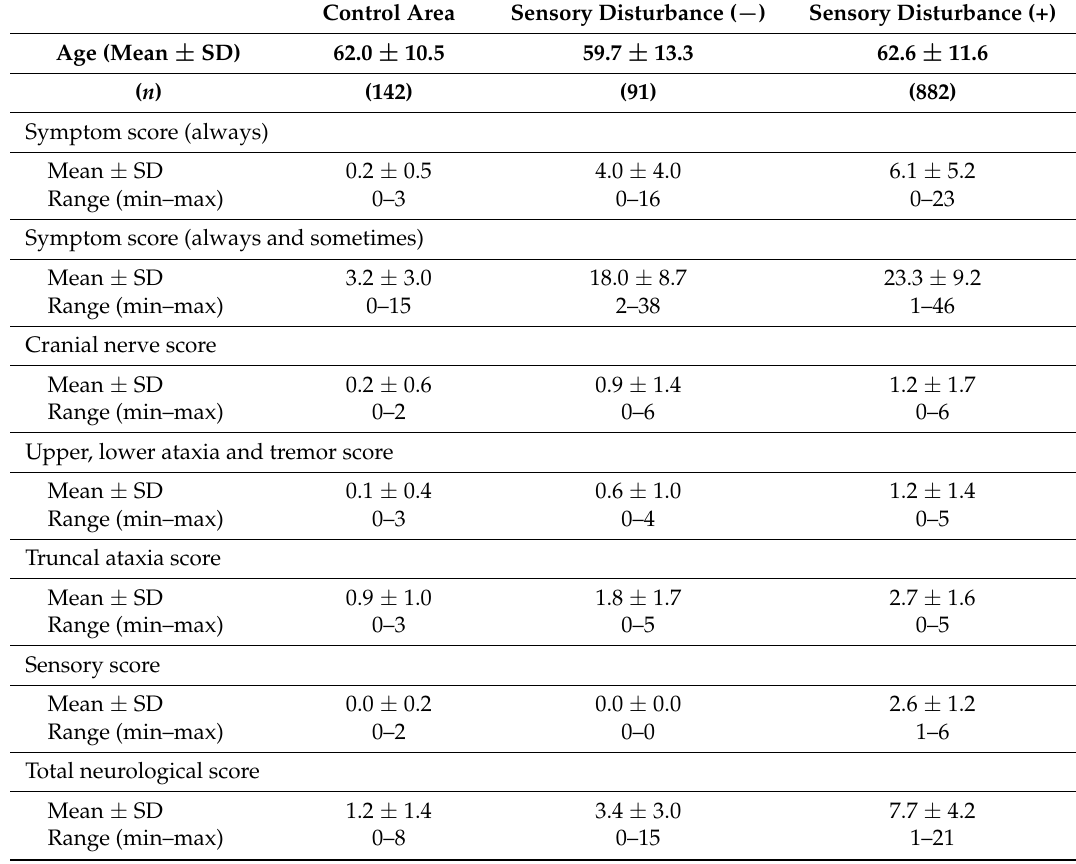
Table 18. Score of signs and symptoms in subjects with and without sensory disturbance ( n =